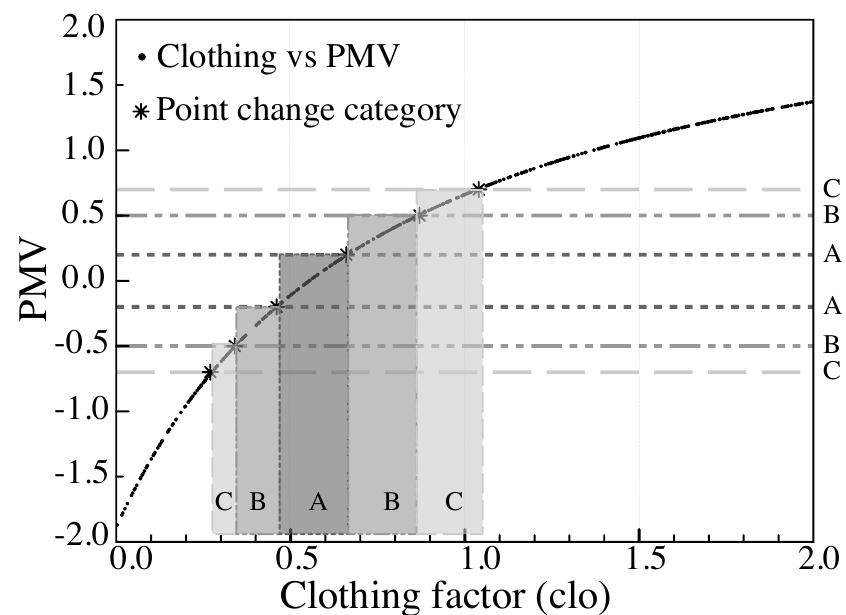
Figure 4. Change of level of thermal comfort in base of sensitivity analysis of clothing factor on PMV.